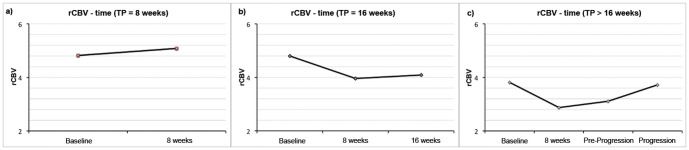
Mean rCBV changes according to treatment response within time.a) Mean rCBV remained elevated in non responsive patients who progressed after 8 weeks of treatment. b) Mean rCBV resulted in a significant decrease at 8 weeks, and in a new increase at 16 weeks, when progression occurred at 16 weeks. c) Mean rCBV showed a decrease at 8 weeks also in patients who progressed at 24 weeks or later but in the following MR performed before progression a light continuous increase of rCBV was observed.